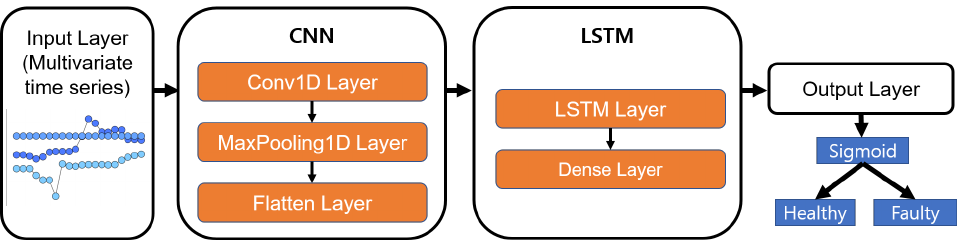
Figure 7. Proposed CNN-LSTM